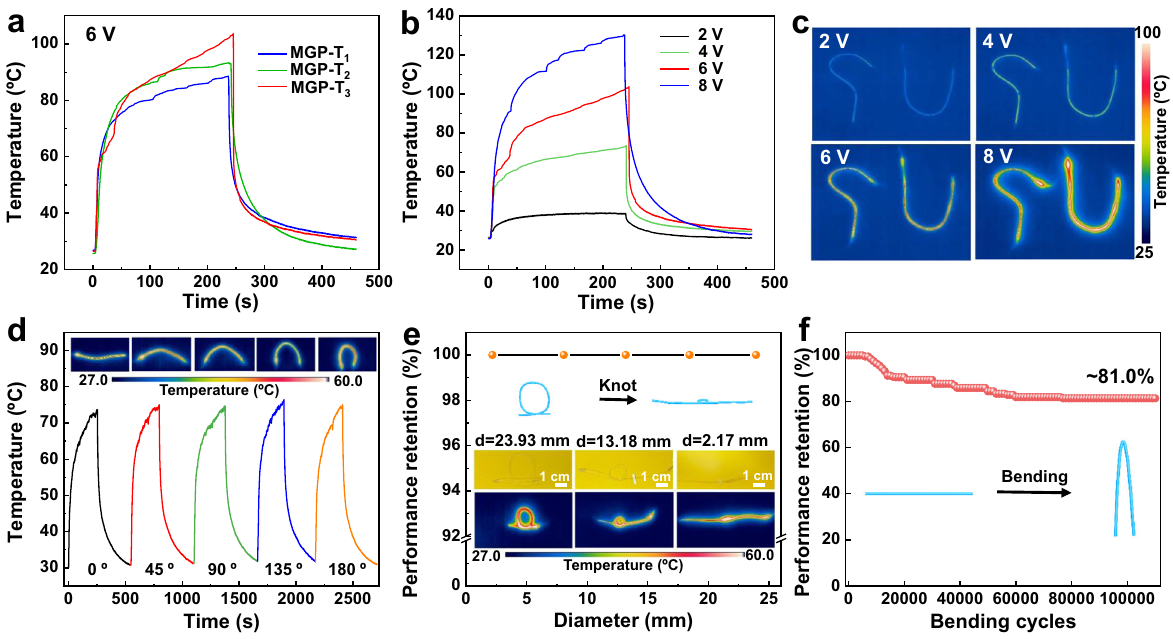
Fig. 6 | Applications for electrothermal heat management. Temperature-time curves of MGP-T fi bers when applied DC voltage of 6 V ( a ) and 2 V-8 V ( b ). c PhotographyofMGP-T fi berswithdifferentlettershapeswhenappliedvariousDC voltageof2V-8V. d Temperature-timecurvesofsingleMGP-T fi bersatthebending